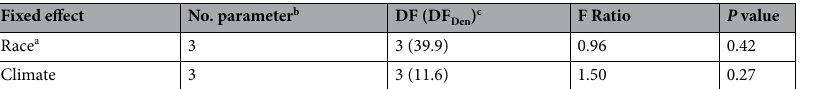
Table 2. Summary of the fit of a mixed model for doubling-time data of Botryococcus braunii wild strains. Model R 2 = 0.79; n = 380; AIC = 1570; BIC = 1609. Fixed Effects Tests. a The Race (A, B, L, S) was estimated based on the molecular phylogeny of 18S rRNA sequences (See Hirano et al. 31 ). b Number of parameters associated with the effect. c Degrees of freedom associated with the effect (Denominator degrees of freedom in